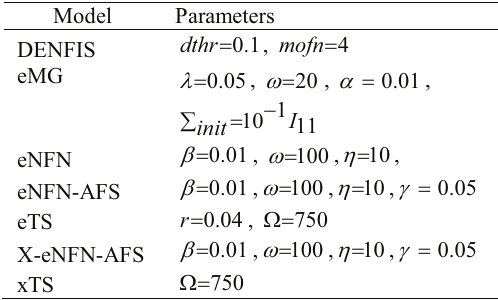
Figure 7. Structure evolution and variable selection of X- eNFN-AFS for nonlinear system identification.